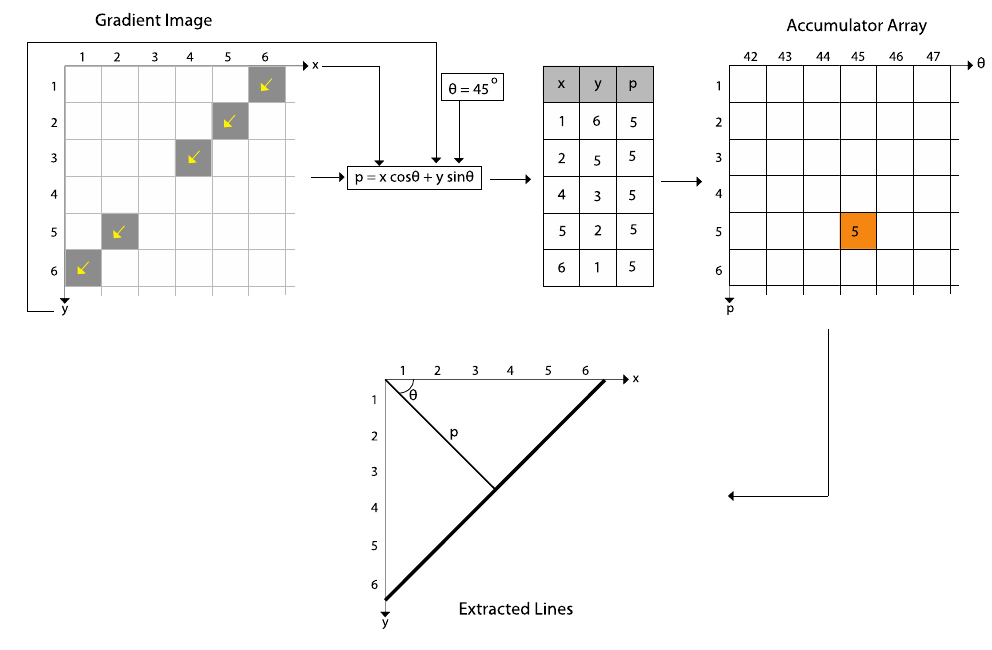
Figure 5. Simplified flow chart for Hough transform